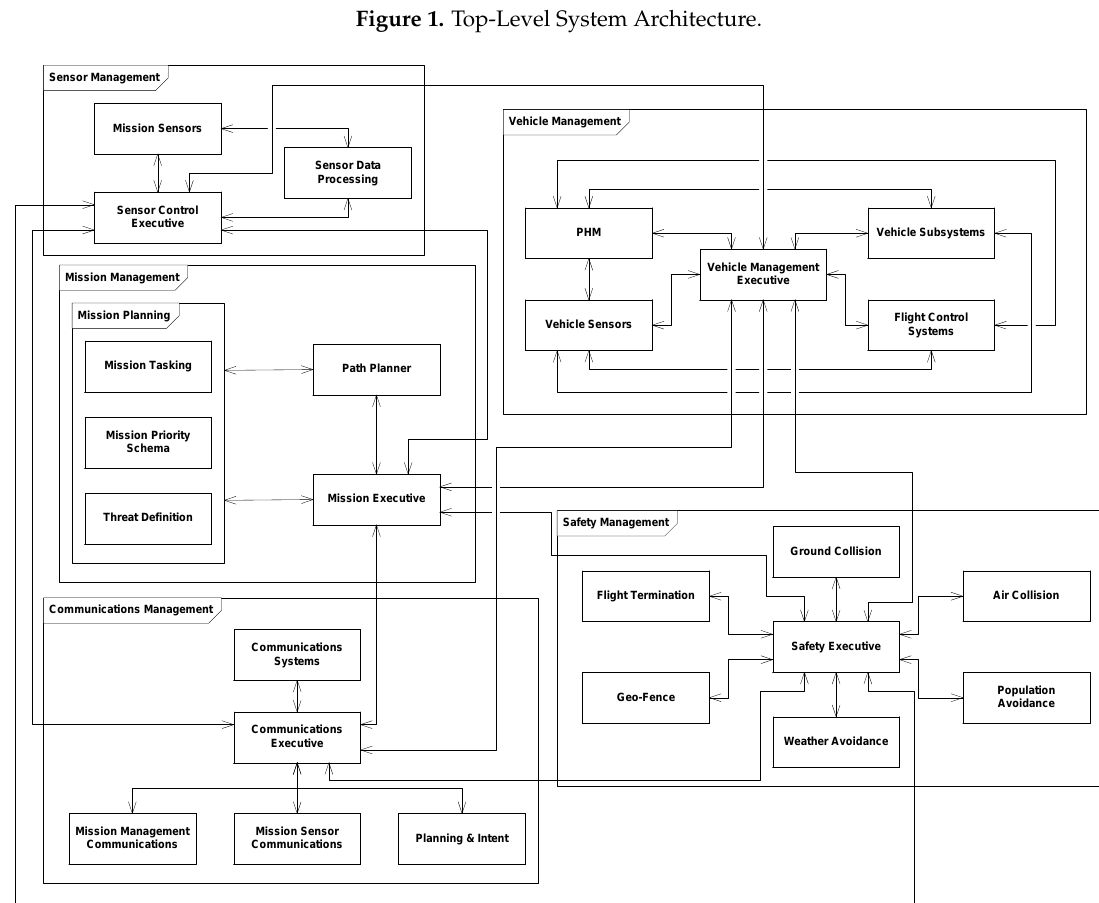
Figure 2. Detailed System